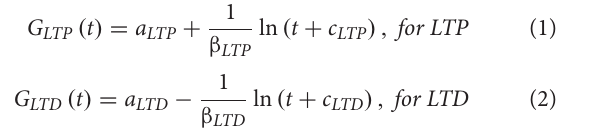
different V BG values. Since V O above a certain value (e.g., 1.5